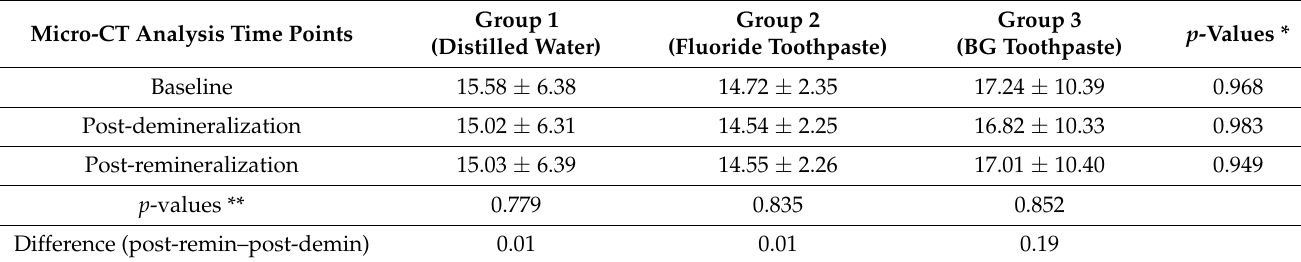
Table 3. Showing mean ± SD enamel volume (mm 3 ) as shown by micro-CT for the three groups at different analysis time points. Micro-CT Analysis Time Points